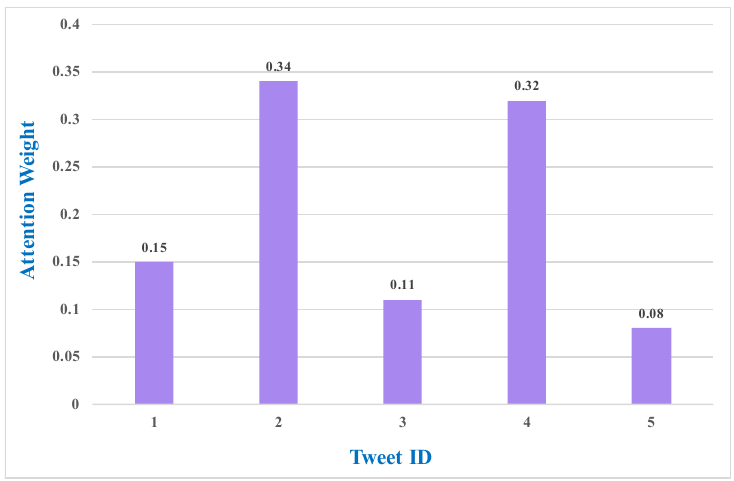
Figure 5. Attention weights learned by the proposed ASpamDetector for the example in Figure